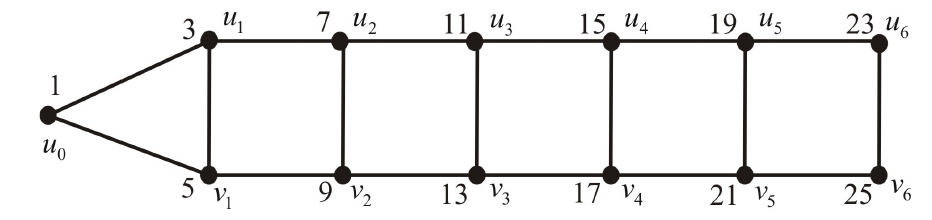
and its odd prime y